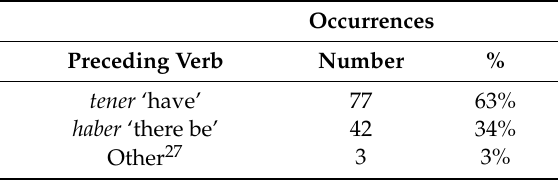
Table 4. Verbs preceding que + infinitive (N =